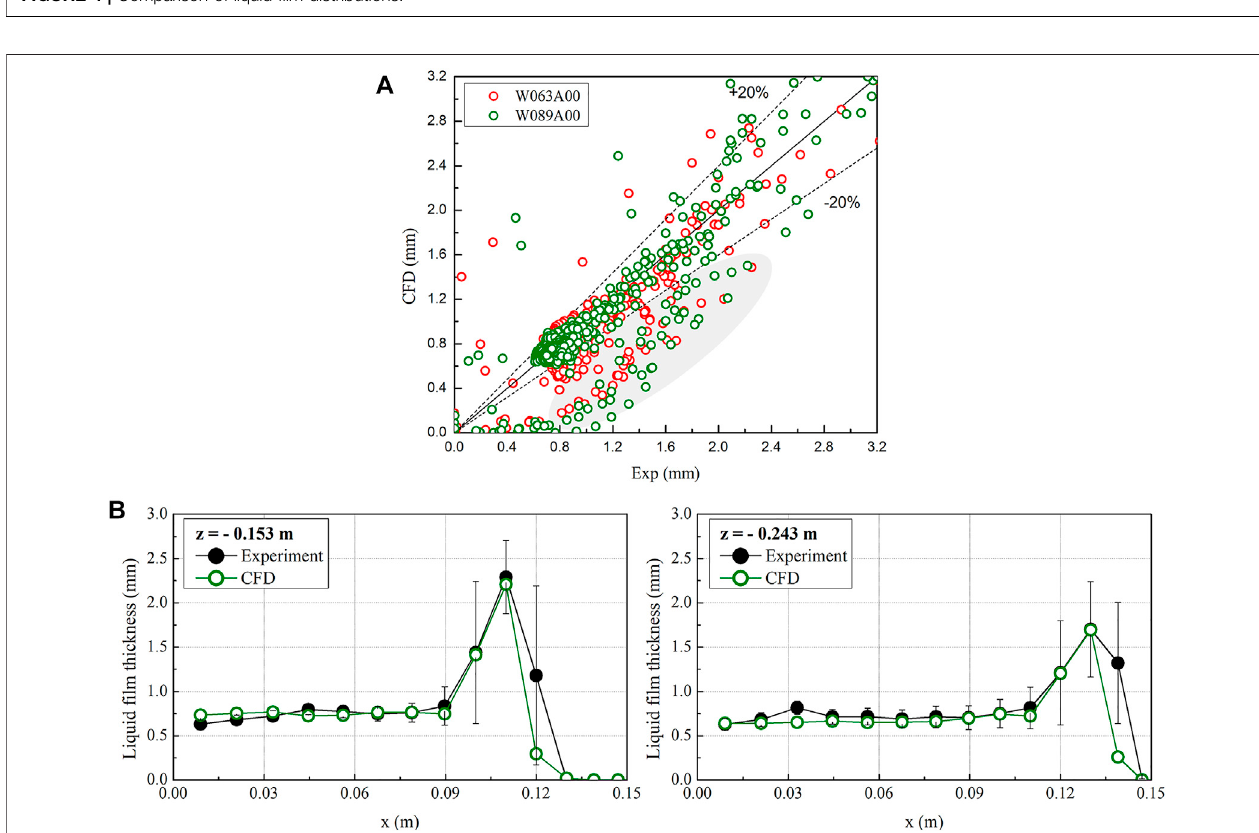
FIGURE 5 | (A) Quantitative comparison of liquid fi lm thickness. (B) . Large discrepancies in fi lm thicknesses near the fi lm boundary (W089A00).